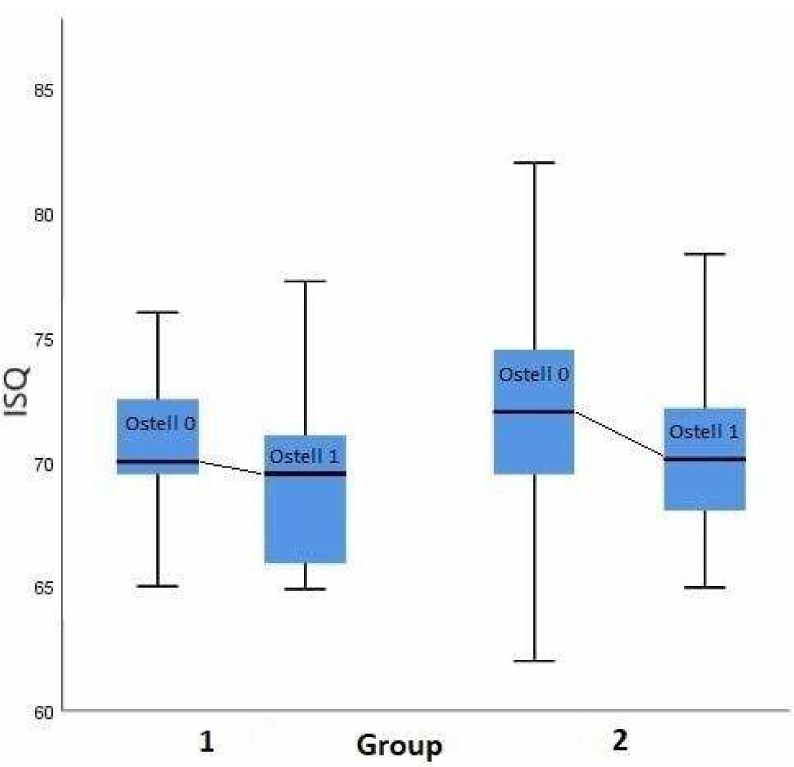
Figure 4. Results of the primary (Ostell 0) and secondary (Ostell 1) stability in both groups.